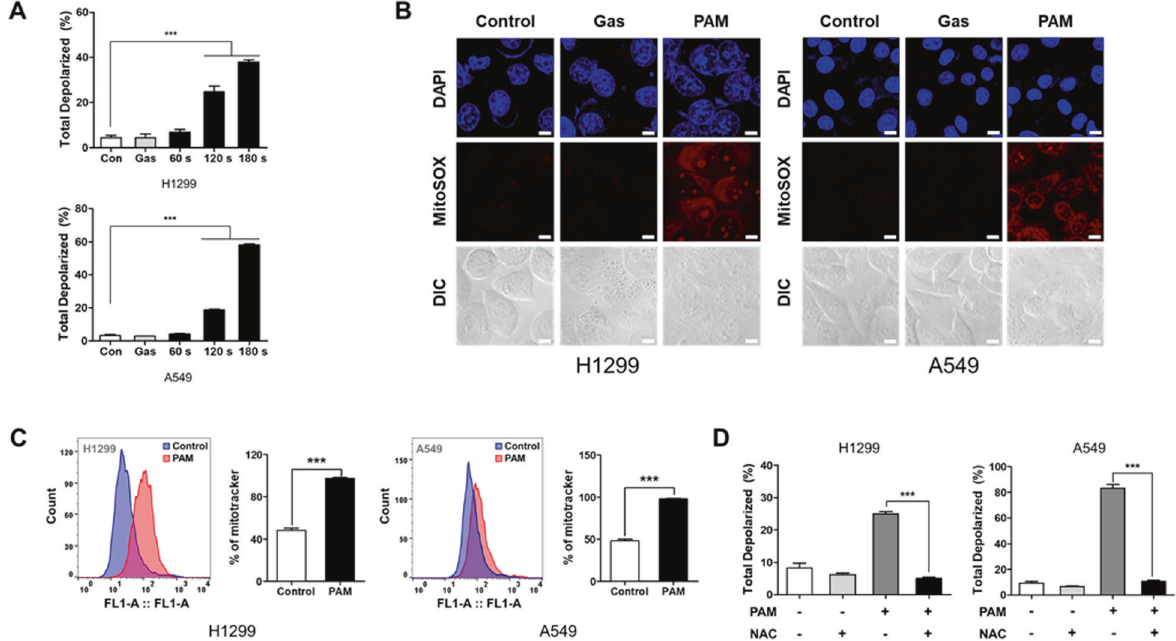
Fig. 2 Mitochondrial dysfunction causes by plasma-activated medium. The plasma exposure conditions were 1.9 standard liter per minute (SLM), 7 W input power and three exposure times (60, 120, and 180 sec). A PAM increased the proportion of total depolarized mitochondria. Cells were treated with PAM for 24 h. B Levels of mitochondrial superoxide was observed by MitoSOX fl uorescence using confocal microscopy. H1299 and A549 cells were treated with PAM (180 sec) for 2 h. Scale bar = 10 μ m. C Mitochondrial biogenesis was detected by Mitotracker using fl ow cytometry. Cells were treated with PAM (180 s) for 24 h. D N-acetylcysteine (NAC) inhibited mitochondrial depolarization by PAM. Cells were treated with PAM (180 s) for 24 h. Data represent the mean ± SD from three independent experiments (*** p < 0.001, as determined by t